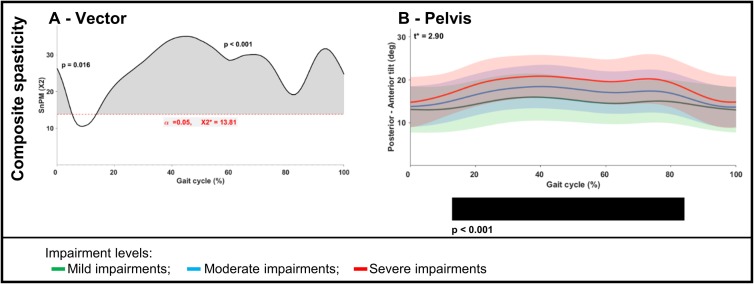
Statistical non-parametric mapping output example for the correlation of the composite spasticity score and gait in children with uCP.(A) Non-parametric Canonical Correlation analysis (SnPM{X2}) output example for the correlation of sagittal plane kinematics (vector with four components) with the composite spasticity score in children with uCP. Two suprathreshold clusters were found (cluster 1: 5%, p = 0.016; cluster 2: 86%, p < 0.001). The bold black line represents the computed X2-curve, the dashed red line indicates the random field theory threshold calculated for this test (at 13.81 for α < 0.05). The composite spasticity score associated with the sagittal motion vector of children with uCP for a total of 91%. (B) Post-hoc scalar field non-parametric linear regression analysis (SnPM{t}) output example for the correlation between pelvic motion and the composite spasticity score in children with uCP (α = 0.0125). One cluster was identified (71%, p < 0.001). The impairments were divided into 3 categories, depicted as mean (bold line) and standard deviation (translucent area): mild (green color), moderate (blue) and severe (red), indicating that the higher the impairment, the stronger the. The black bars underneath the figures represent the suprathreshold clusters that were formed when the critical threshold (t*) was exceeded and the null hypothesis was, therefore, rejected. Abbreviation: uCP: unilateral cerebral palsy.